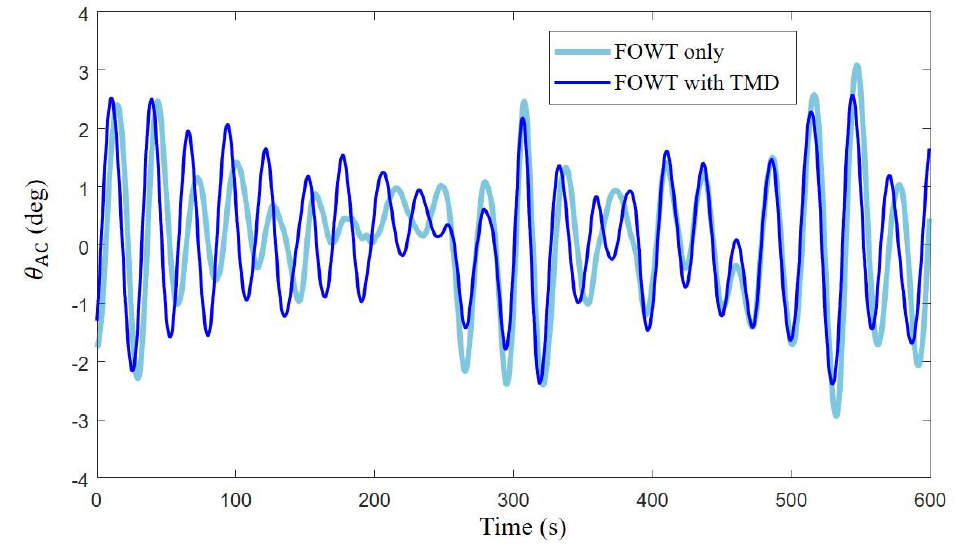
Figure 4. Pitch motion of the FOWT in the presence of stochastic winds and waves. The average wind speed is 11 m/s.